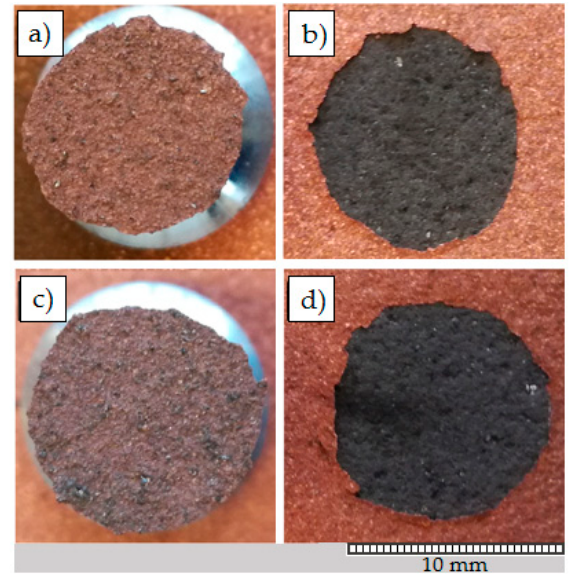
Figure 14. Surfaces of corresponding test dollies ( a , c ) and graphite composite substrates ( b , d ) after pull-off test.